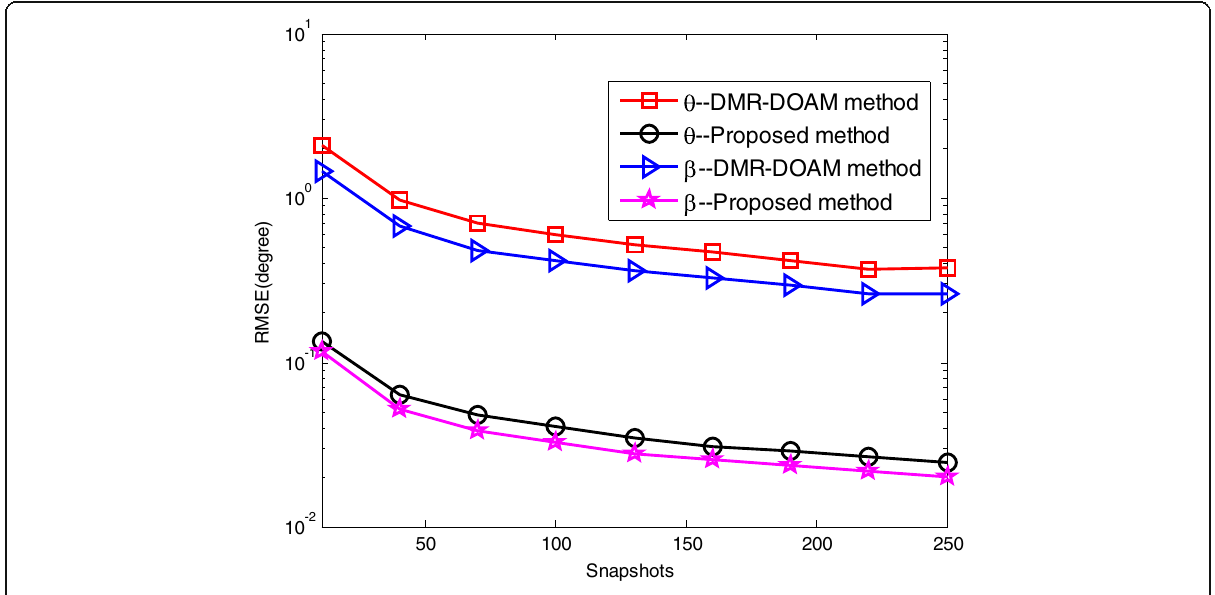
Fig. 4 The RMSE of the DOA estimates versus input